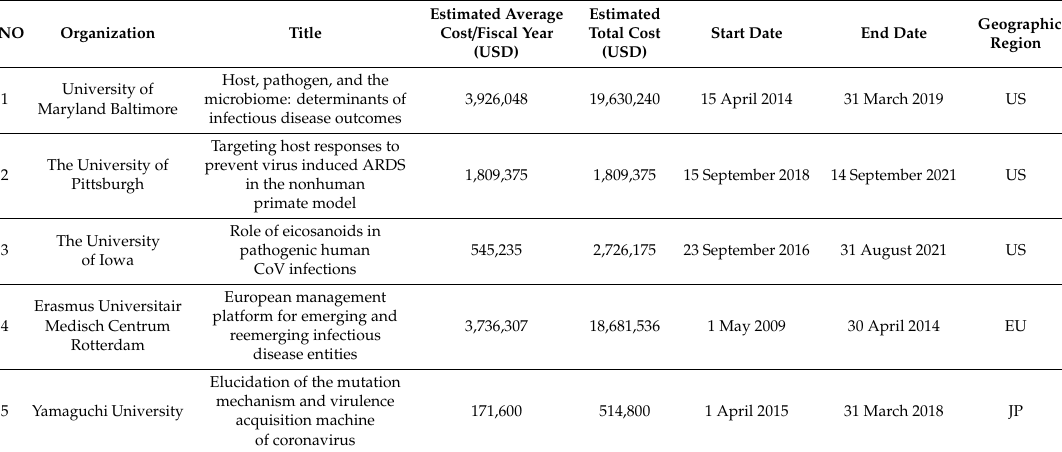
Table 2. Research related to the mechanisms of infection, the life cycle of SARS-CoV-2, and the identification of a virus–host interaction mechanism (Sub-Cluster 1-1).